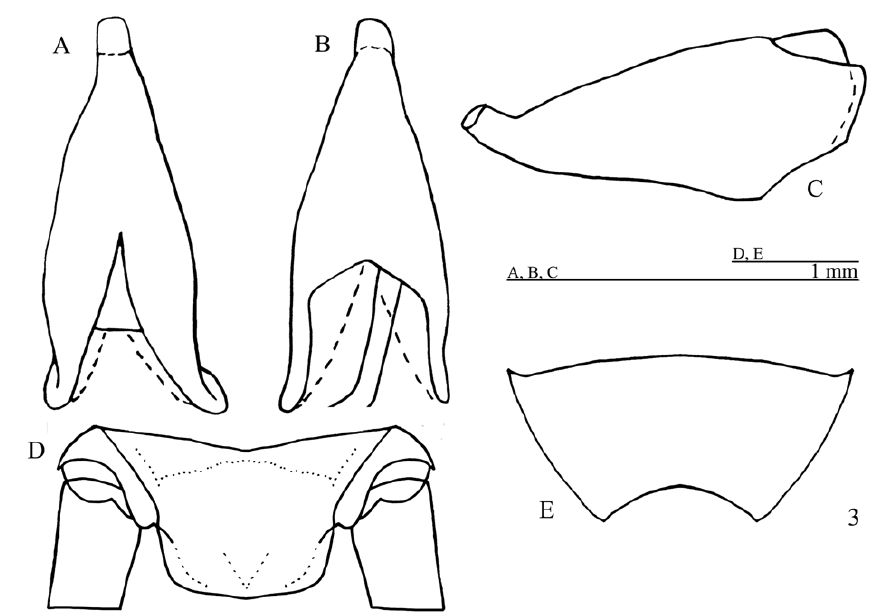
Fig. 3 – P. arenita sp. nov. Female copulatory papilla. A. dorsal, B. ventral and C. lateral views. D. Female supra-anal plate. E. Female subgenital